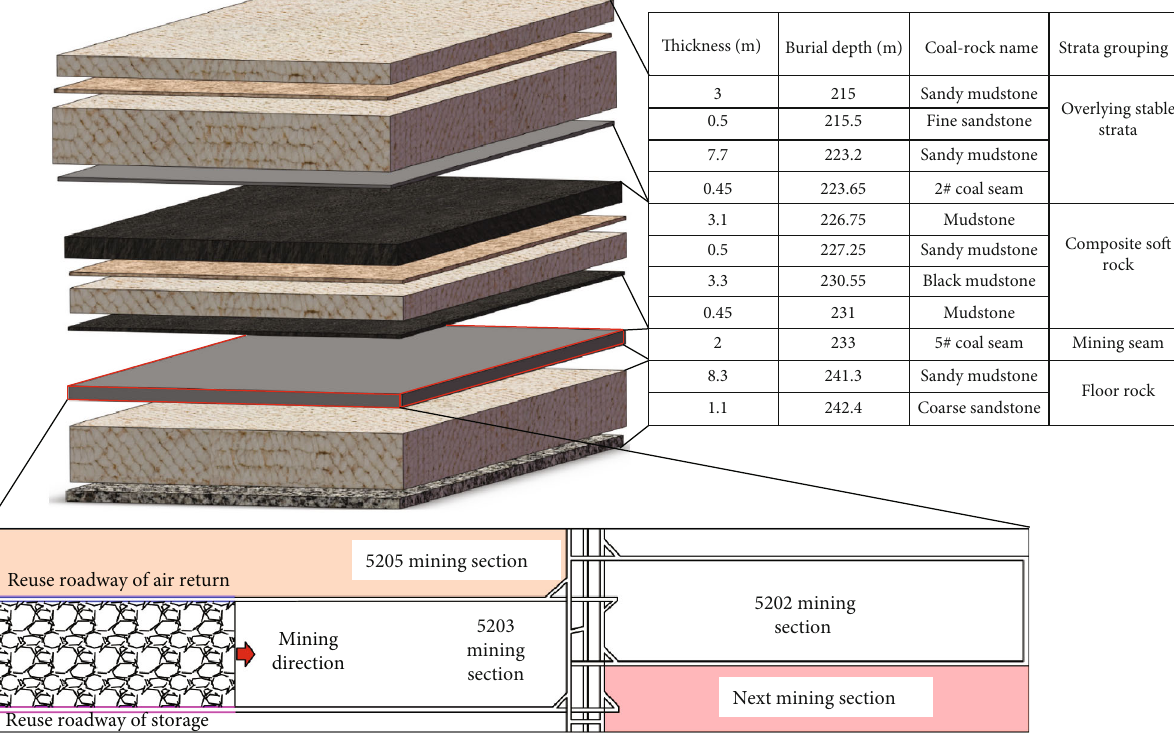
Figure 1: Geological structure of strata.